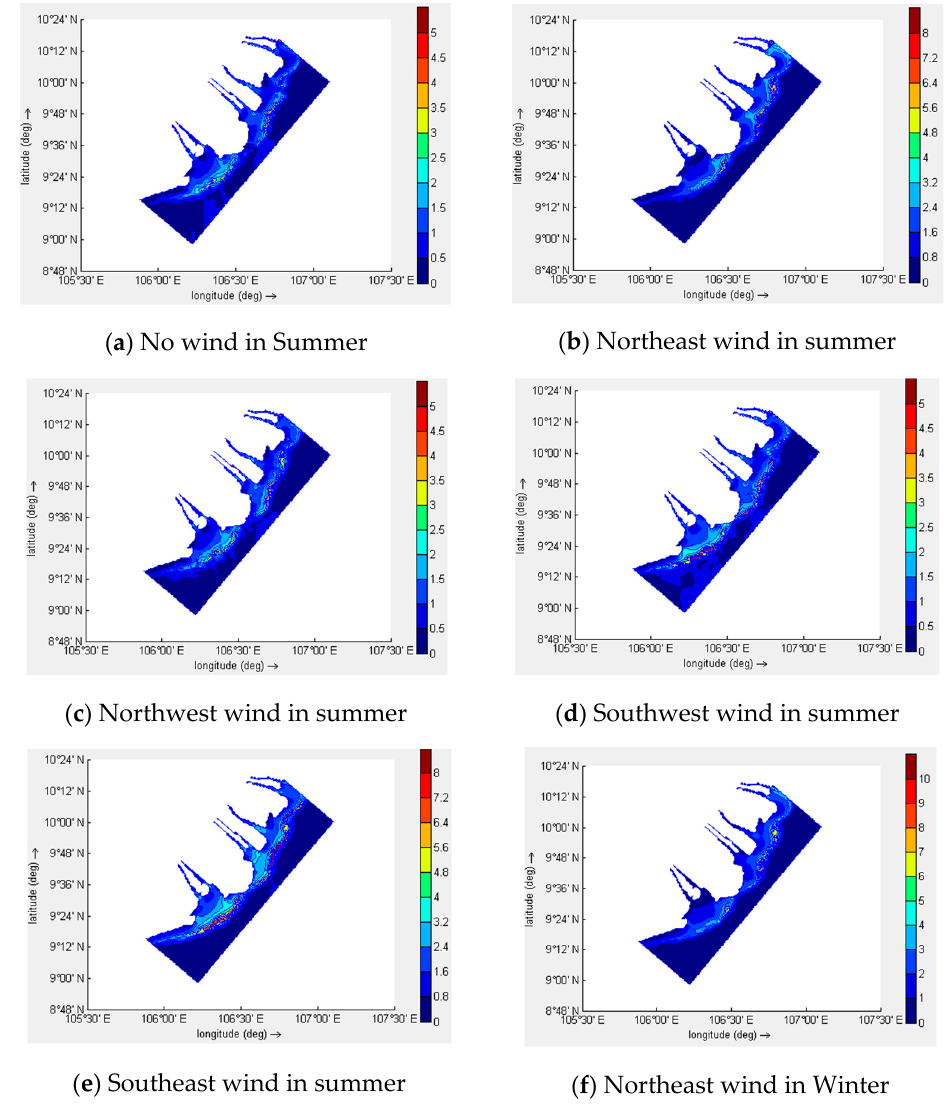
Figure 4. The shear stress on the bottom bed at the Mekong River Delta under no wind ( a ), northeast wind ( b ), northwest wind ( c ), southwest wind ( d ), southeast wind ( e ) in summer and northeast wind ( f ) in winter (Unit: Pa).